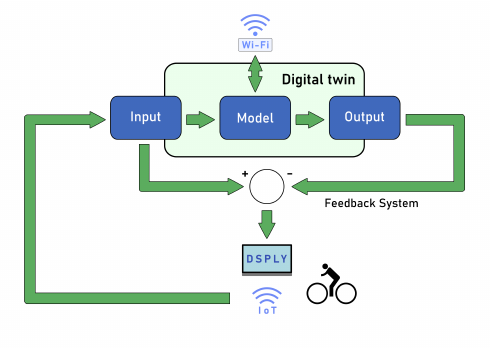
Figure 2. Scheme of the proposed digital twin model for